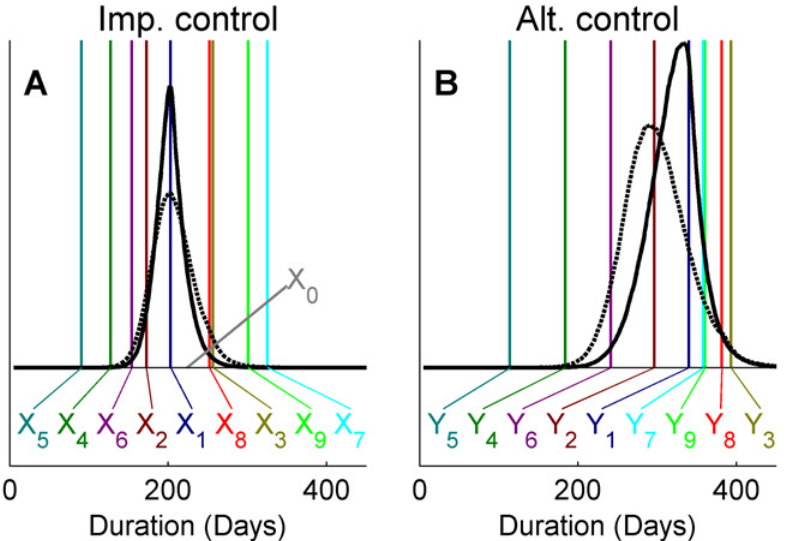
Fig 6. Ensemble prediction of outbreak duration with Q = 1 and Q = 3. Posterior estimates of mean outbreak duration for the implemented (Panel A) and alternative (Panel B) control action, with the dashed line indicating the posteriors corresponding to the single quantity analysis and the solid line indicating the corresponding posterior when number of infected and control culls are included. The figure shows the result of the large discrepancy